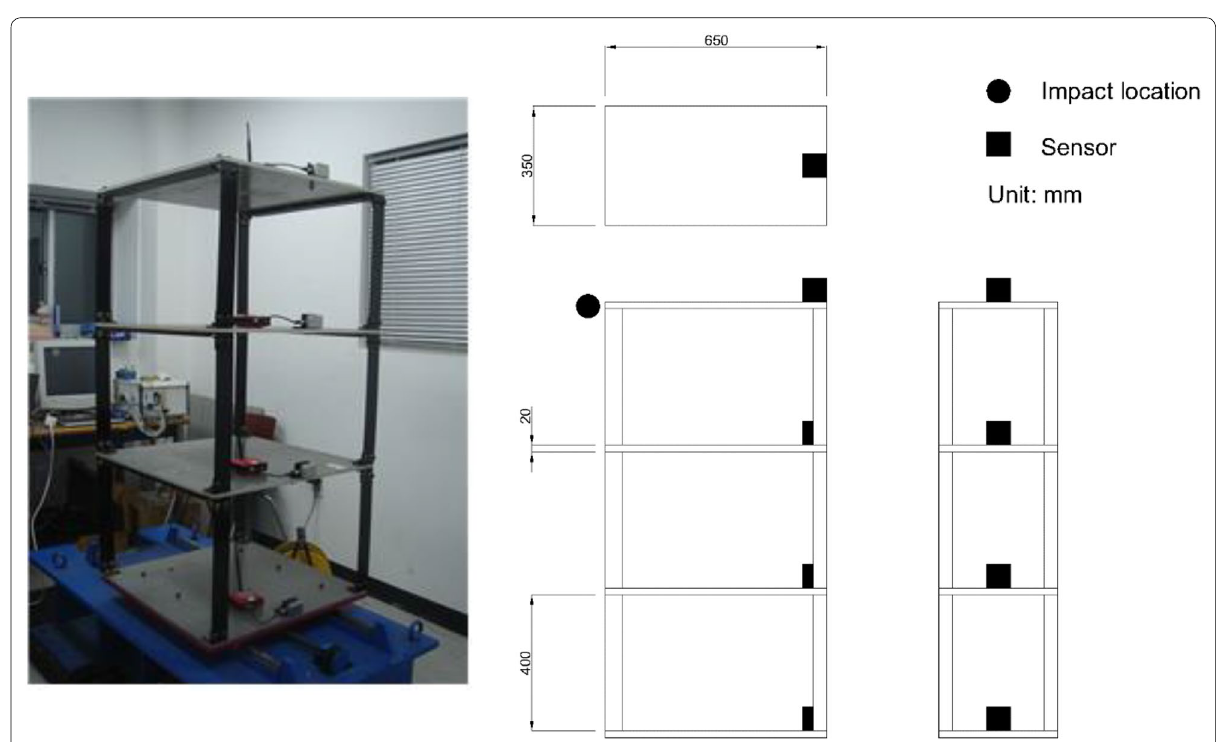
Fig. 3 Three‑story steel structure.